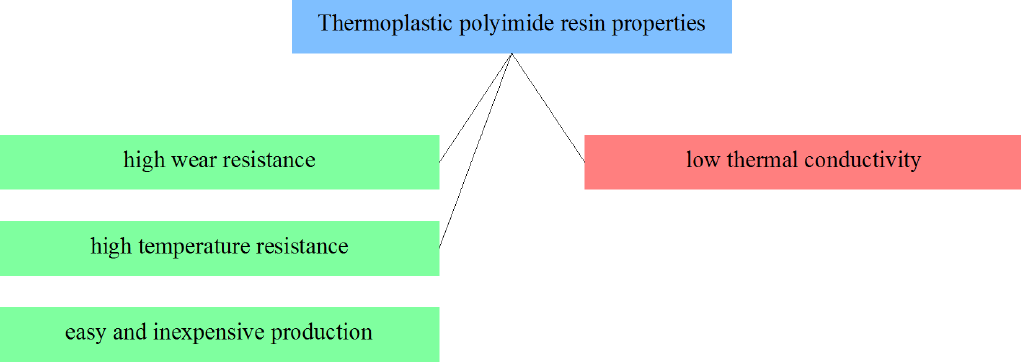
Figure 9: Selected thermoplastic polyamide resins properties from the point of view of applicability in friction materials